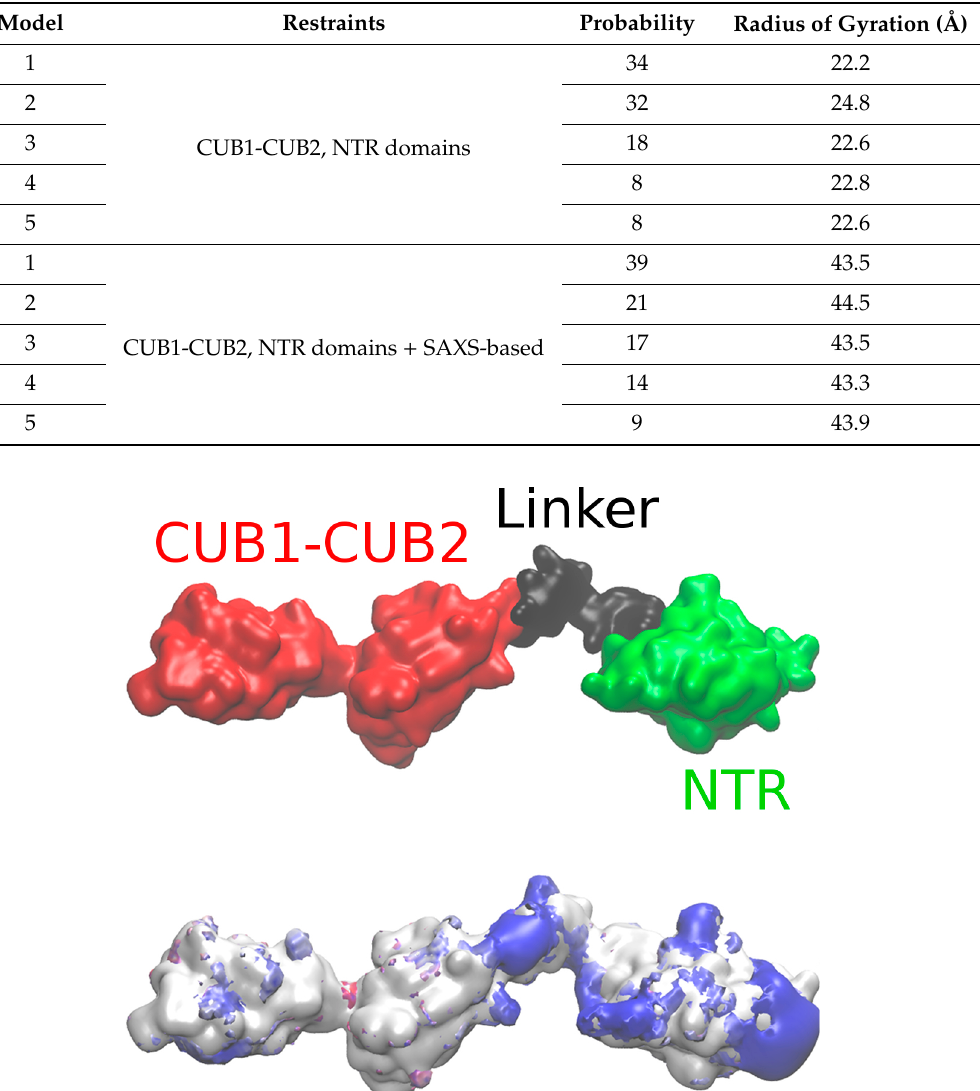
Table 1. Models of the full-length PCPE-1 obtained using UNRES coarse-grained (CG) simulations.